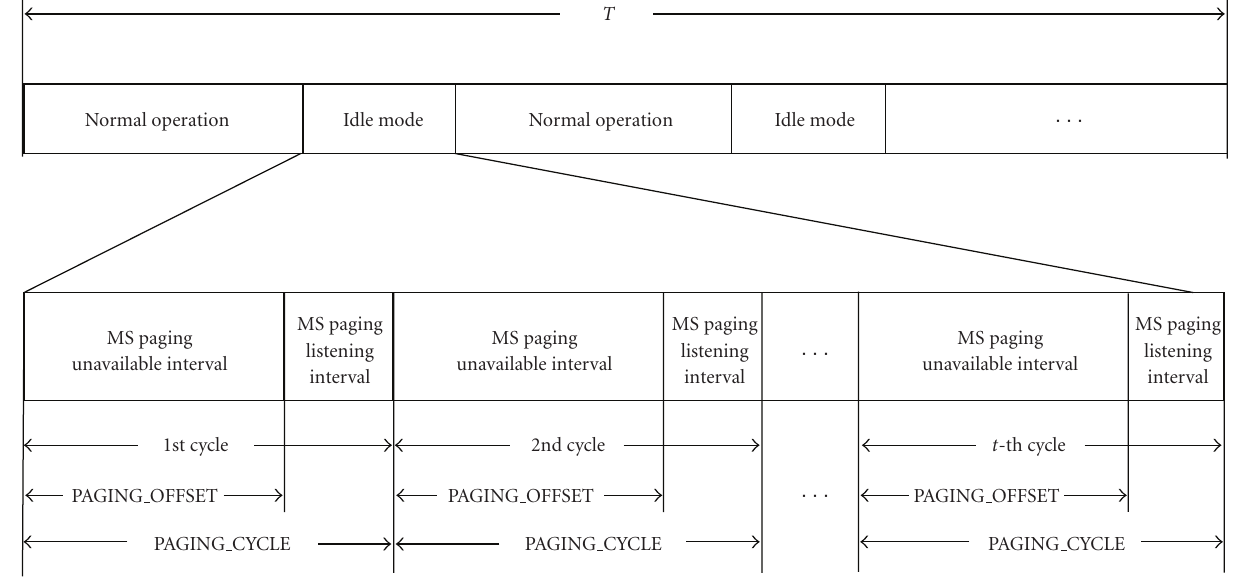
Figure 8: Active mode and idle mode